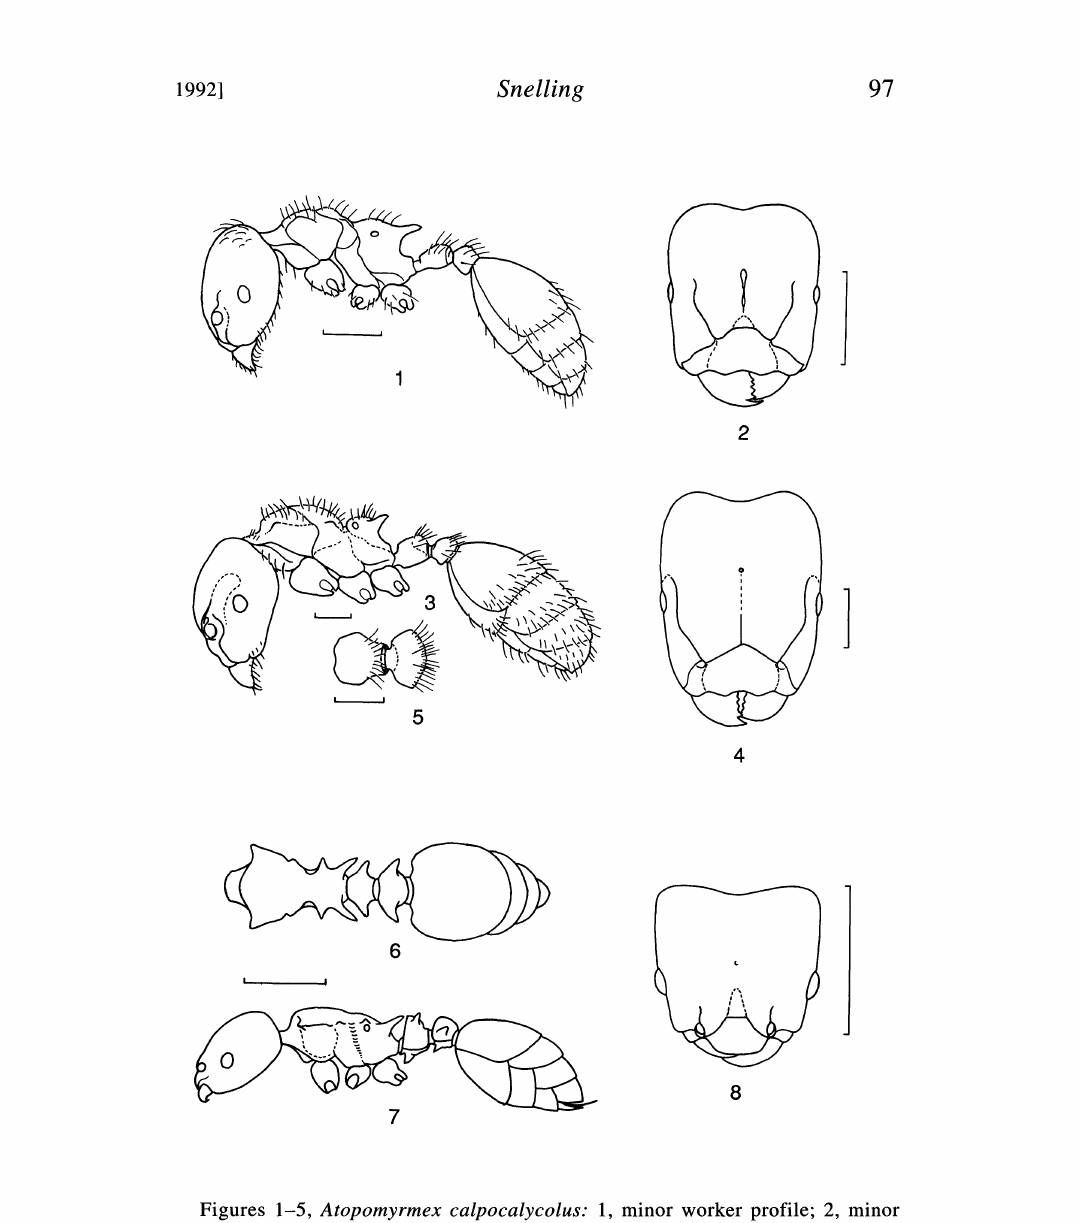
Figures 1-5, Atopomyrmex calpocalycolus: 1, minor worker profile; 2, minor worker head, frontal view; 3, major worker profile; 4, major worker head, frontal view; 5, petiole and postpetiole, dorsal view. Figures 6-8, Leptothorax catalau- coides, worker: 6, meso- and metasoma, dorsal view; 7, head and body, lateral view; 8, head, frontal view. Scale lines 0.50 mm. Figures by Tina